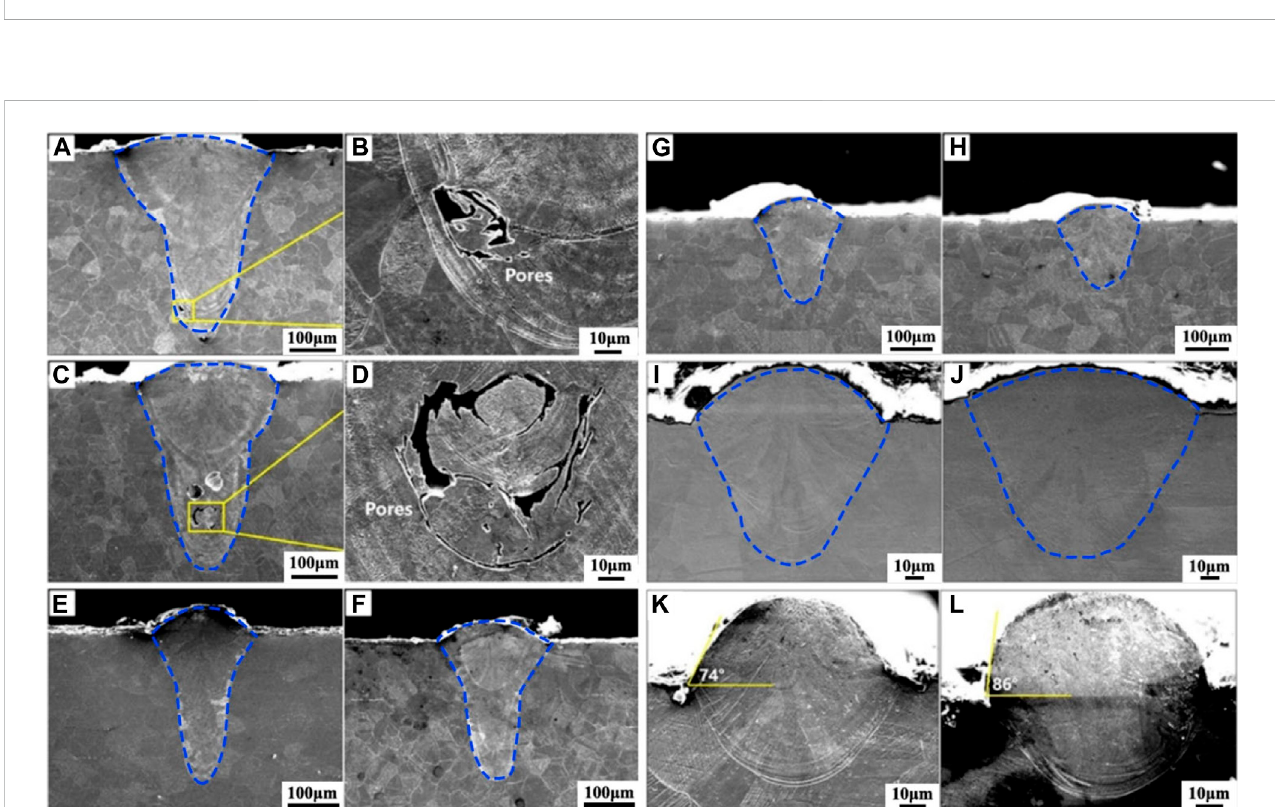
FIGURE 3 SEMmorphologyofthesinglemoltentrackcross-sectionunderdifferentlaserparameters (A,B) P=200 W,V=100 mm/s,LED=1019 J/mm 3 (C,D) P= 180 W,V=100 mm/s,LED=917 J/mm 3 ; (E) P=200 W,V=200 mm/s,LED=510 J/mm 3 ; (F) P=180 W,V=150 mm/s,LED=611 J/mm 3 ; (G) P=200 W,V= 300 mm/s,LED=340 J/mm 3 ; (H) P=200 W,V=400 mm/s,LED=255 J/mm 3 ; (I) P=130 W,V=400 mm/s,LED=166 J/mm 3 (J) P=160 W,V=500 mm/s, LED = 163 J/mm 3 (K) P = 100 W, V = 700 mm/s, LED = 73 J/mm 3 (L) P = 100 W, V = 1000 mm/s, LED = 51 J/mm 3